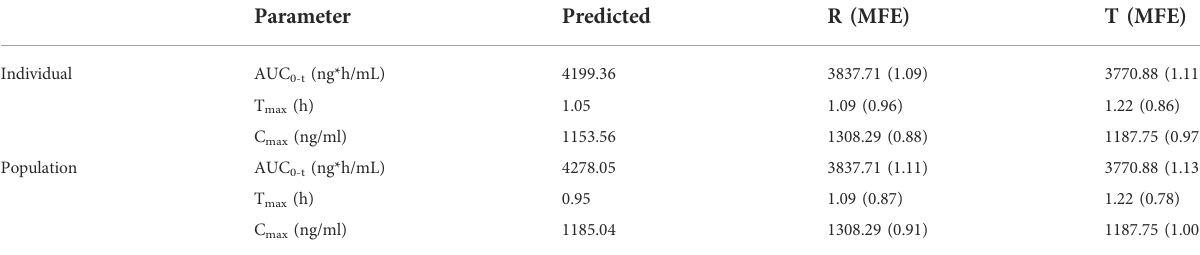
TABLE 4 Predicted and observed values pharmacokinetic parameters of 50 mg PTU